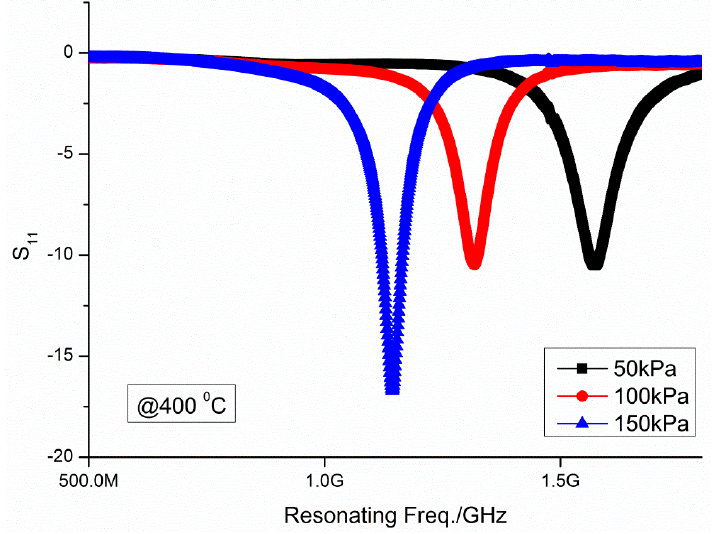
Figure 4. Scatter parameter S 11 vs. frequency plots of the developed sensor.